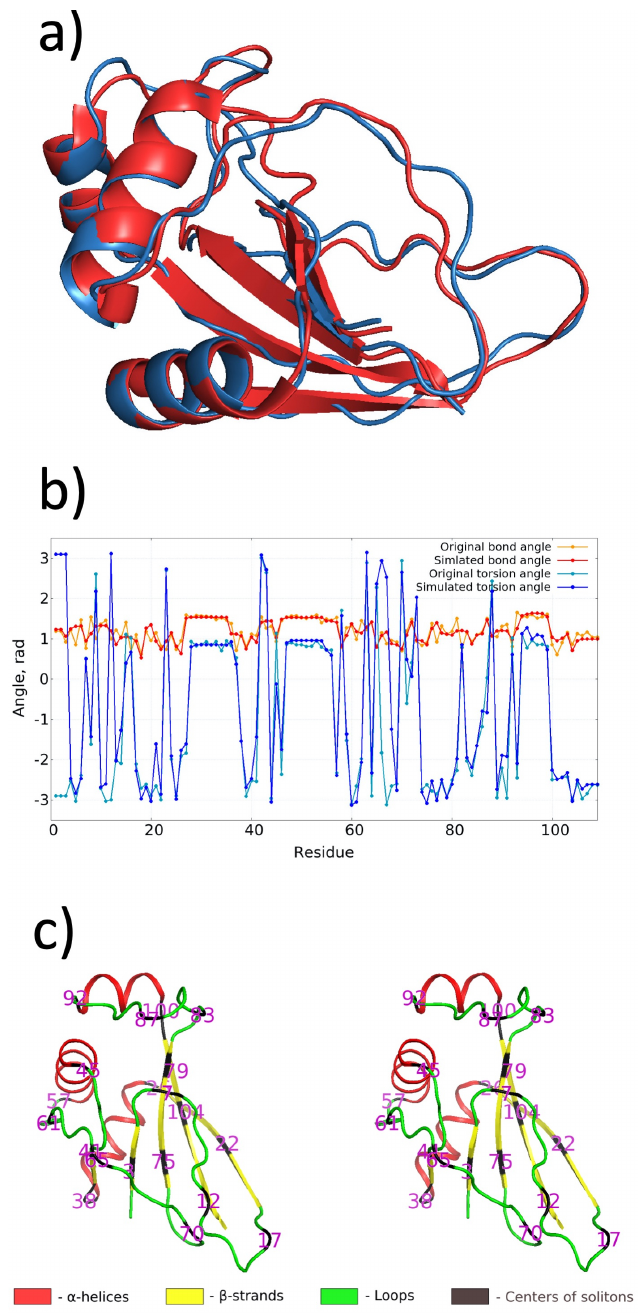
Fig 2. Panel a) shown overlay comparison of PDB structure 2J6B (red) and its multi-soliton structure (blue). The RMS distance between the two structures is 1.23 Å . Panel b) shows the virtual C α trace bond and torsion angles, for the PDB structure 2J6B and for its multi-soliton model. Panel c) is a cross-eye 3D view that identifies the secondary structures of 2J6B, together with the individual soliton centers.